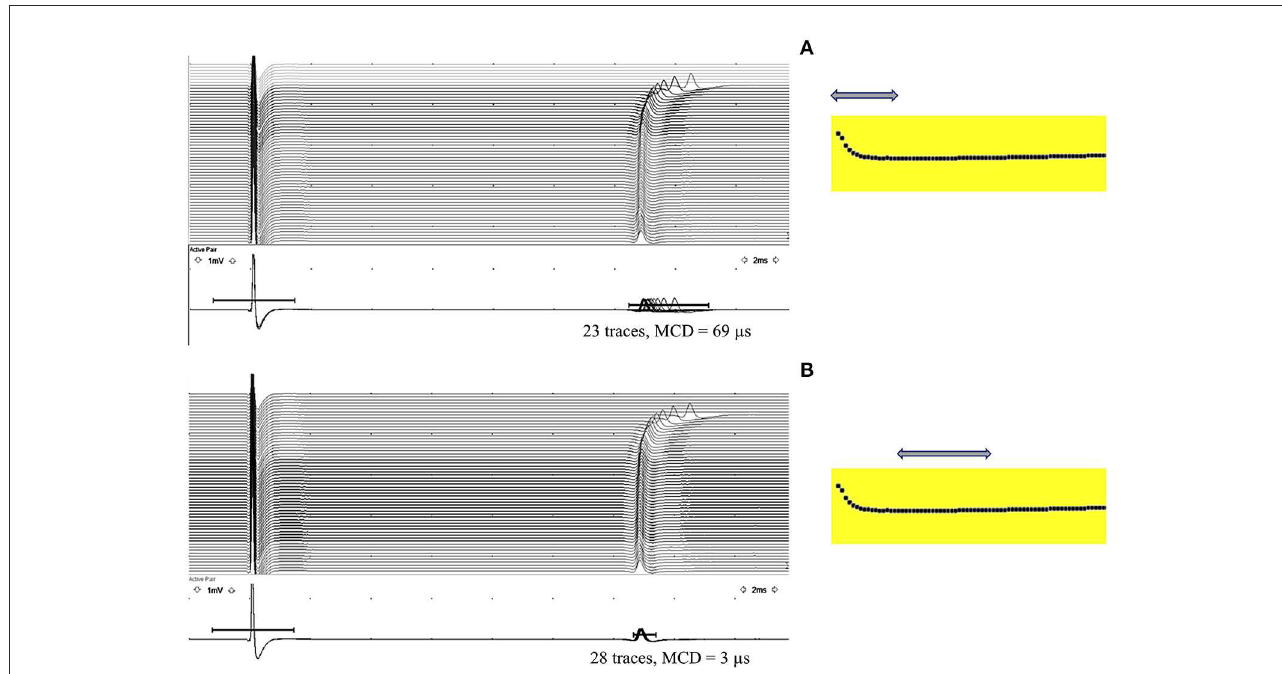
FIGURE8 Velocity recovery function (VRF) is typically seen in the first second of a 10-Hz electrical activation. (A) Observe a progressive latency reduction in the first 10 muscle fiber action potentials (MFAPs), with a mean consecutive difference (MCD) of 69 µ s measured from 23 MFAPs (arrow). (B) After the initial latency reduction, stabilization occurs with an MCD of 3 µ s measured from 28 MFAPs (arrow), compatible with a direct muscle fiber activation.